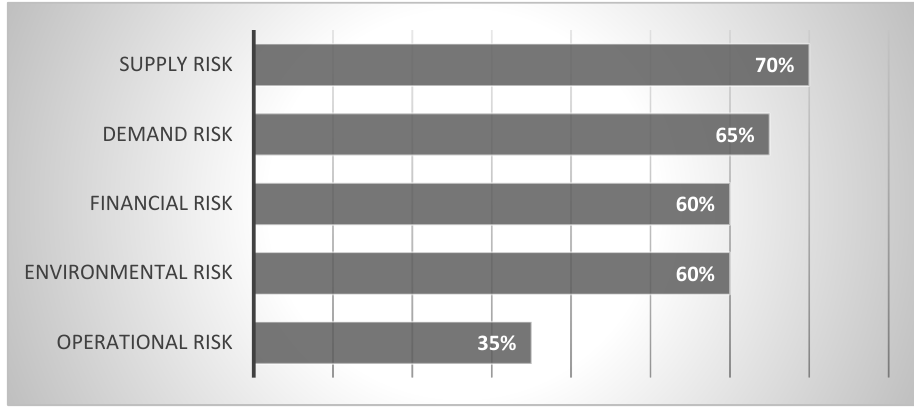
Figure 1. Australian clothing retailers’ responses to SCR.